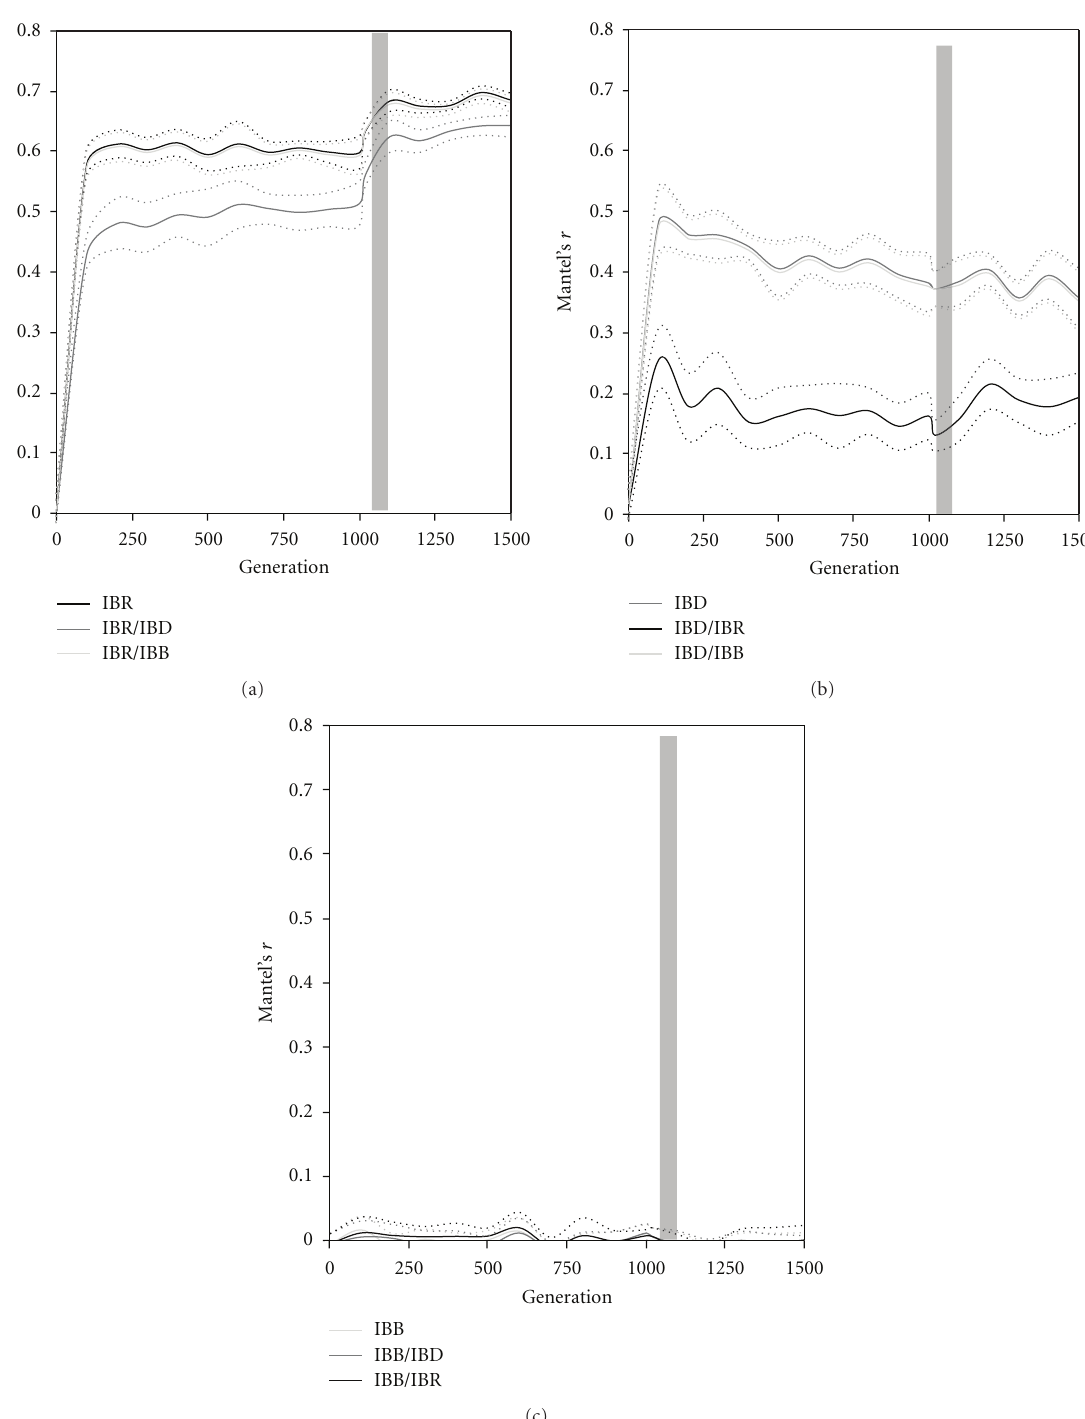
Figure 2: Correlation between observed empirical genetic distance ( Y ) and simulated genetic distance ( Y (cid:2) ). (a), the simple Mantel correlation between Y and Y (cid:2) for the IBR landscape is depicted across 1500 simulated generations (black line). Partial Mantel correlations controlling for the variance explained by the IBB hypothesis (light gray line) and IBD hypothesis (dark gray line) are also shown. (b), the simple Mantel correlation between Y and Y (cid:2) for the IBD landscape is depicted (dark gray line), with the partial correlations controlling for the variance explained by the IBR (black line) and IBB (light gray line) also shown. (c), the simple Mantel correlation between Y and Y (cid:2) for the IBB landscape is depicted (light gray line), with the partial correlations controlling for the variance explained by the IBR (black line) and IBB (dark gray line) also shown. In all panels, the gray vertical bar indicates the modern day (generation 1020), and the dotted lines indicate the standard deviation of the Mantel correlations across 10 Monte Carlo